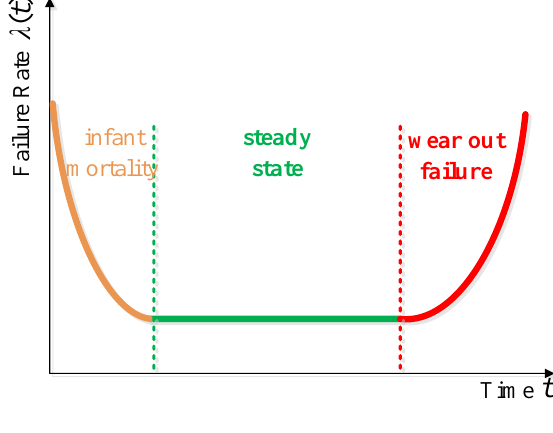
Figure 2. Profile of the failure